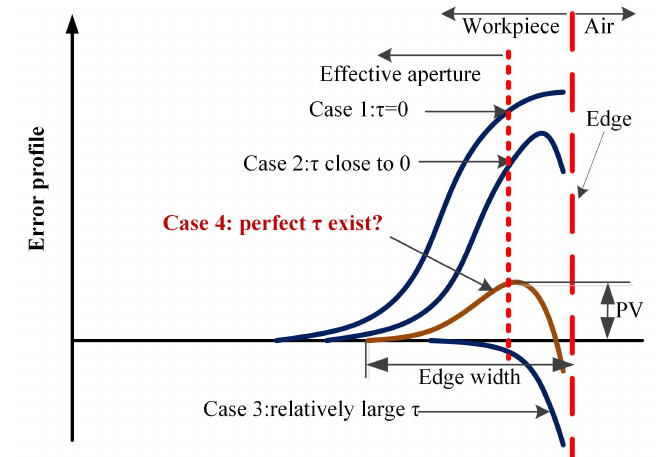
Figure 4. Demonstration of several practical edge effect cases about the error profile of the edge.